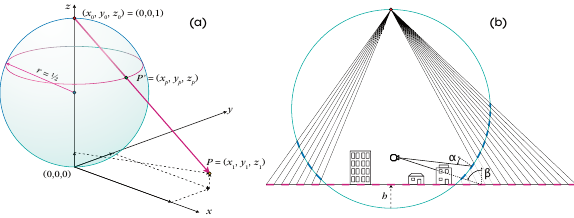
Figure 1. Inverse stereographic projection of a point P in space to P ′ on a sphere (a), and the compression and improvement in viewing angle from the projection in an urban environment